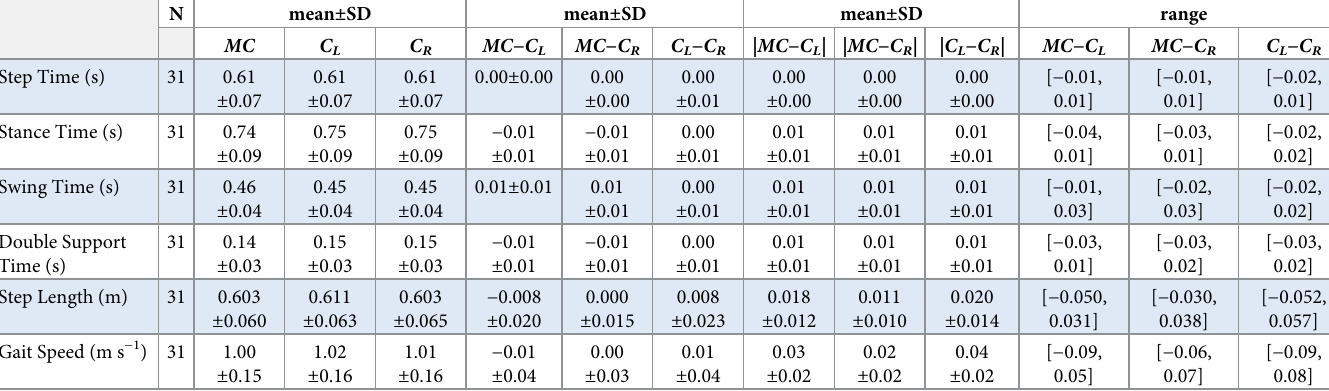
: OpenPose left-side view; C : OpenPose right-side view. L R